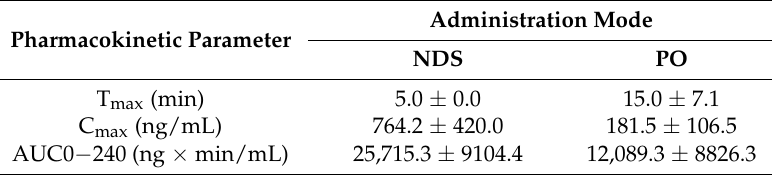
Figure 6. Plasma buspirone concentration-time profile after the administration of buspirone NDS to rat at a dose of 3 mg/kg compared with oral administration (PO). Data given as mean ± SD, n = 5 for each group. * p < 0.05 significant by an unpaired two-tailed t -test. Table 3 . Pharmacokinetic parameters following the administration of 3 mg/kg buspirone in NDS and PO to rat at a similar dose ( n = 5, for each group), mean ± SD.